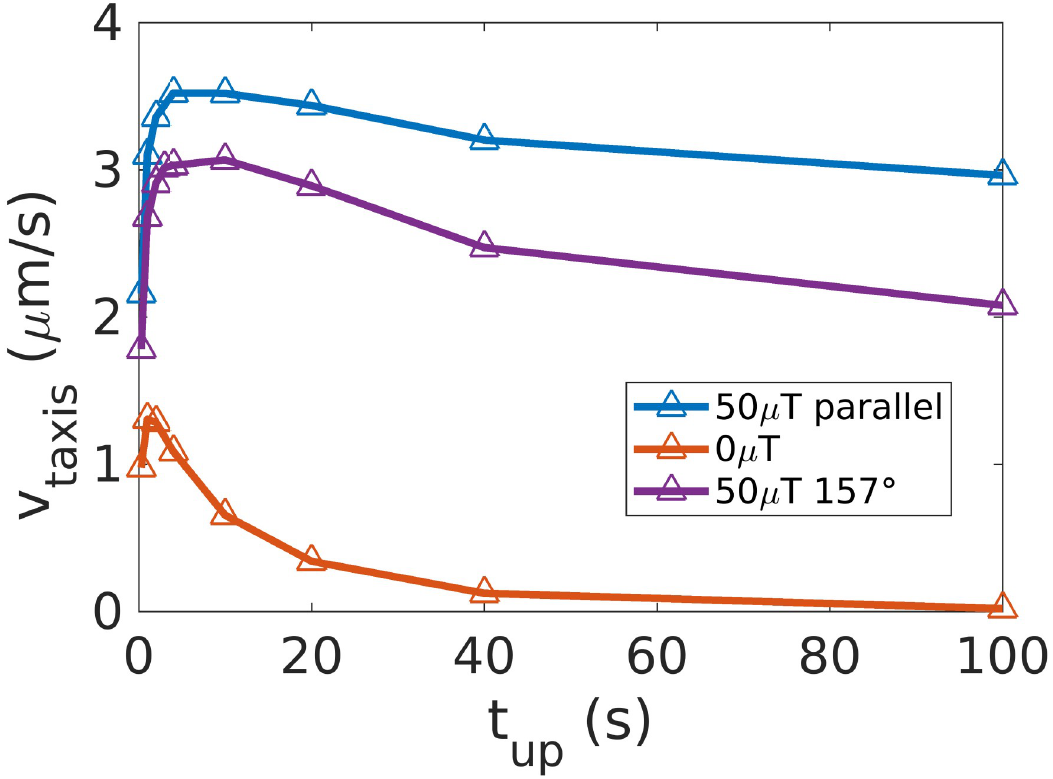
Fig 5. Influence of the mean run time. For run-and-reverse chemotaxis towards an attractant, we study the influence of the mean run time, during which the bacterium swims up the gradient, on the taxis velocity. We notice that for B = 0, a peak is present around 2 s. For B = 50 μT (parallel to the gradient or at an inclination of 157˚ (inclination of the Earth magnetic field in Berlin to a downward gradient in a stratified aqueous environment), a plateau is reached